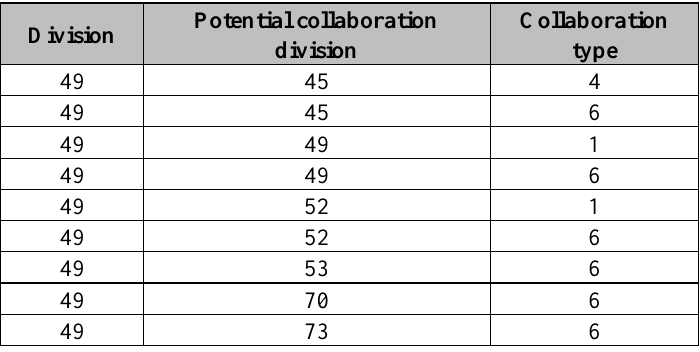
Table 8. All divisions that are affected by knowledge KPI